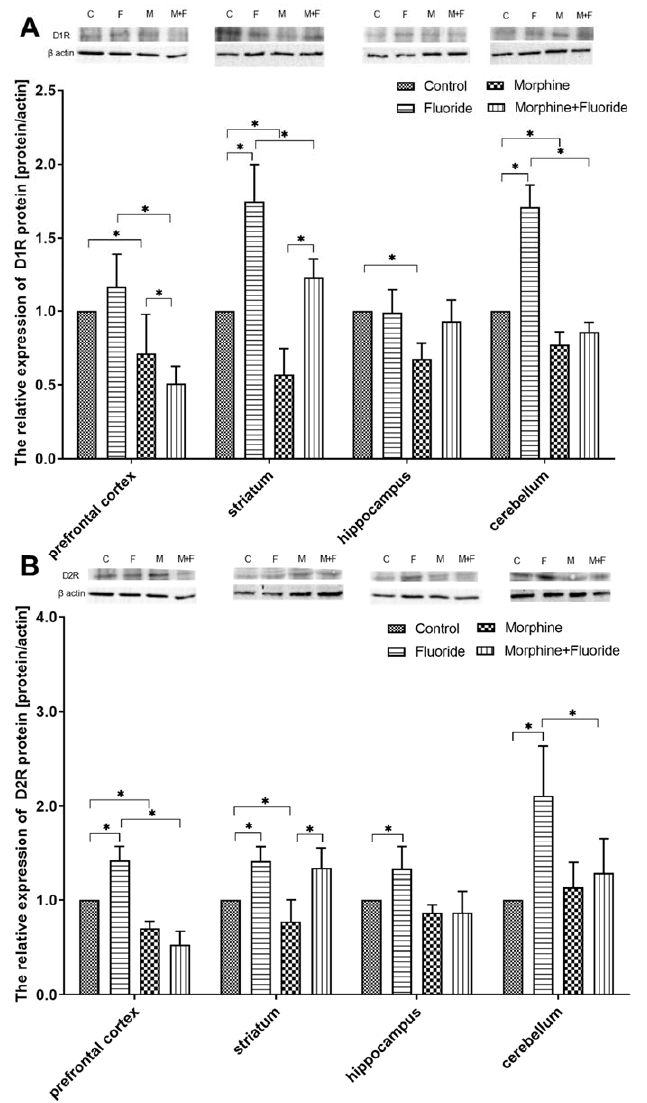
Figure 4. Representative Western blots and densitometric analysis of D1R ( A ) and D2R ( B ) protein expression levels (normalized to β -actin) in the brain of control (C), perinatally F-exposed (F), morphine administered (M), perinatally F-exposed, and morphine administered rats (F + M) in a morphine dependence experimental model in chosen brain structures. The results are expressed as means ± SD. * p < 0.05 (Mann–Whitney U test).